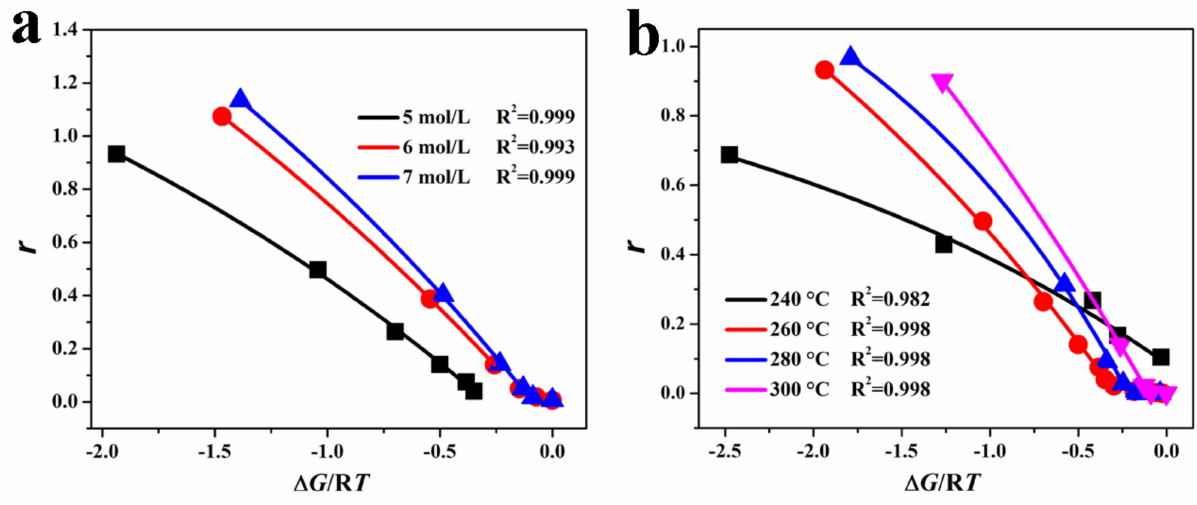
Figure 5. The relationship between dissolution reaction Gibbs free energy ( ∆ r G and reaction rate ( r ), ( a ) concentration-time series experiments, ( b ) temperature-time series experiments. Table 6. The fitting parameter (M) and activity of OH − at different KOH concentration and reac- tion temperatures.